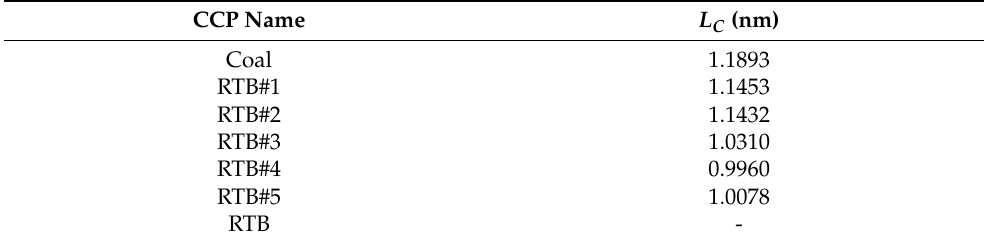
Table 8. L C of the reductant used in the present